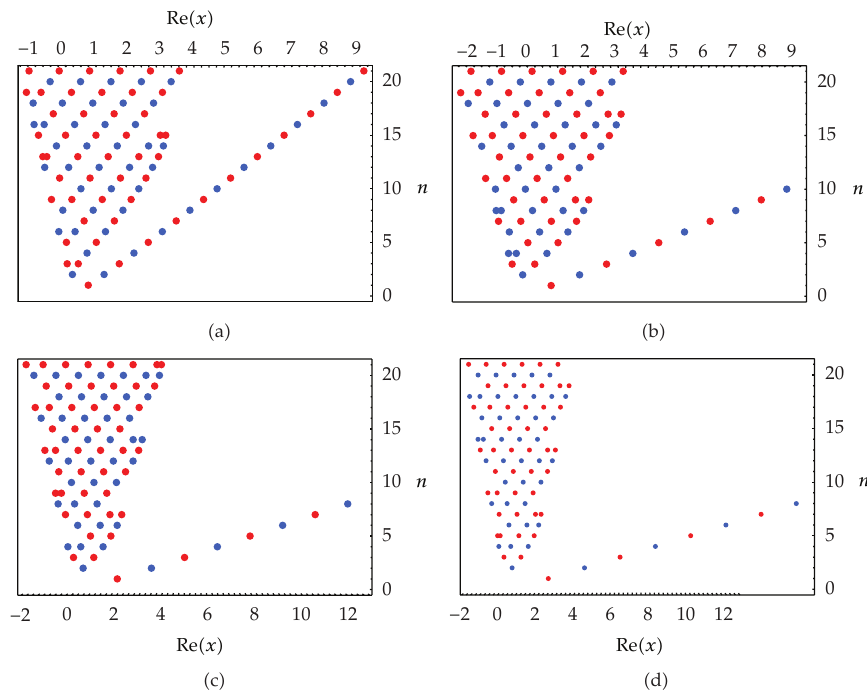
Figure 15: Plot of real zeros of G n,q (cid:2) x (cid:3) for 1 ≤ n ≤